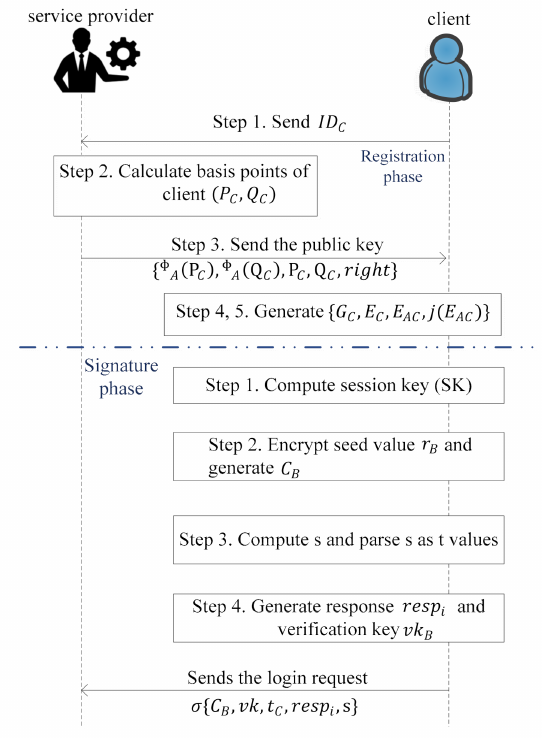
Figure 2. Flow diagram of registration and